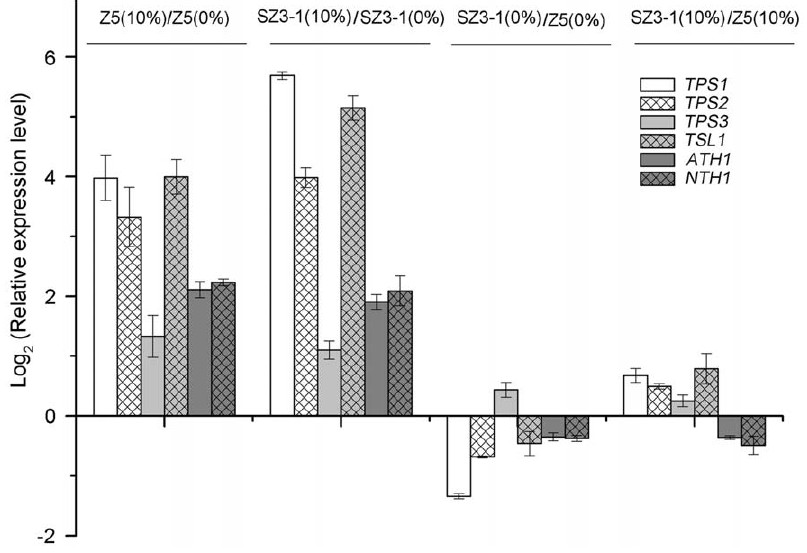
Figure 5. Relative expression level of six genes related to trehalose metabolism. Strains Z5 and SZ3-1 were grown in the absence (0%) or presence (10%) of ethanol. Gene expression of four cases were compared: strain Z5 grown in the presence and absence of ethanol (Z5 (10%)/Z5 (0%)); strain SZ3-1 grown in the presence and absence of ethanol (SZ3-1 (10%)/SZ3-1 (0%)); strain SZ3-1 and Z5 grown in absence of ethanol (SZ3-1(0%)/ Z5(0%)); and strain SZ3-1 and Z5 grown in the presence of ethanol (SZ3-1 (10%)/Z5 (10%)).